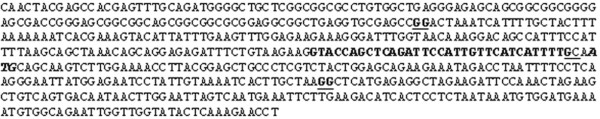
First part of the mRNA sequence of the MMP6 gene. The sequence in bold represents the missing sequence in the smaller PCR product, located upstream of the start codon. Bold and underlined nucleotides represent the exon-exon boundaries The start codon ATG is indicated in bold and italic.